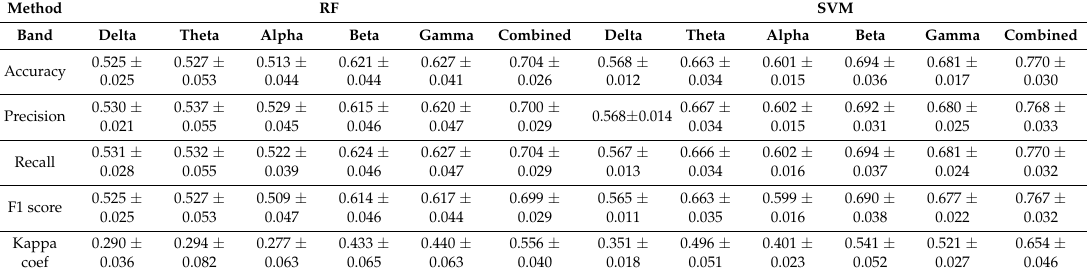
Table 3. Predictive performance with five methods using the differential entropy